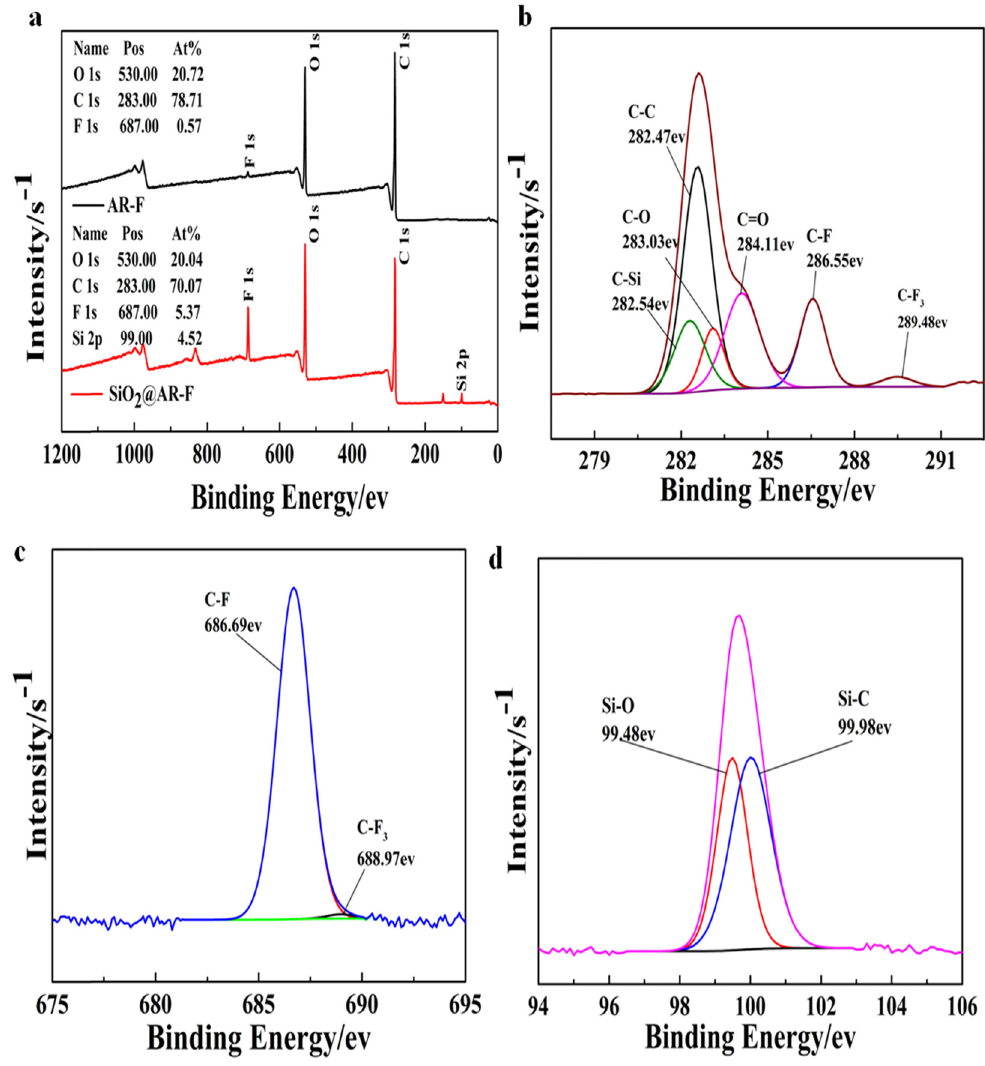
Figure 5: XPS scan spectra of AR - F and SiO 2 @AR - F ( a ) , C 1s ( b ) , F 1s ( c ) , and Si 2p ( d ) scan spectra of SiO 2 @AR - F.